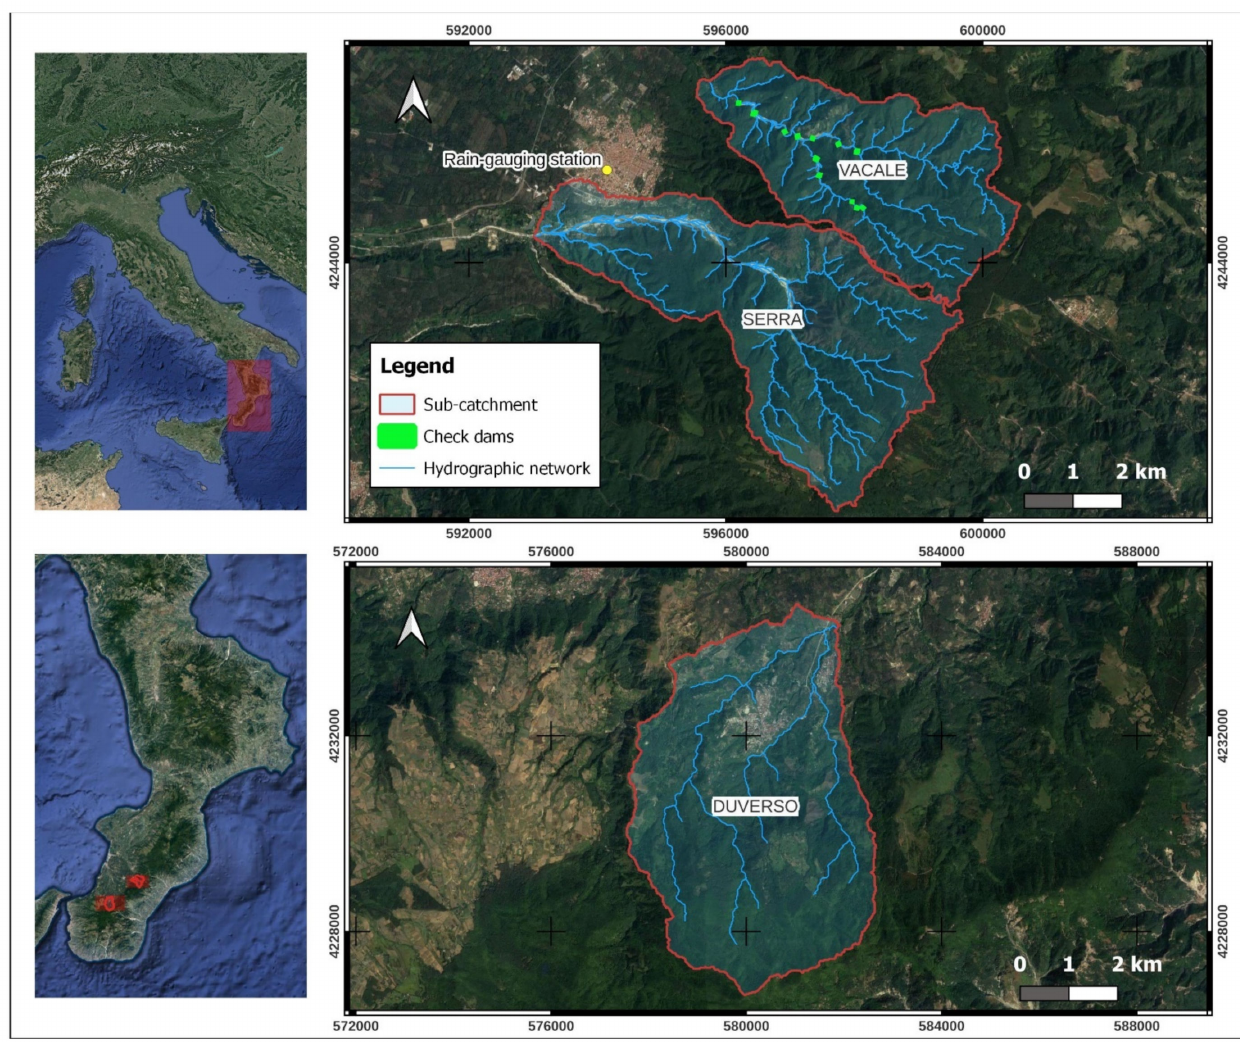
Figure 1. Geographical location ( left ) and aerial map with the hydrographic network and check dam position ( right ) of the studied headwaters (Vacale, Serra, and Duverso torrents, Calabria, Southern